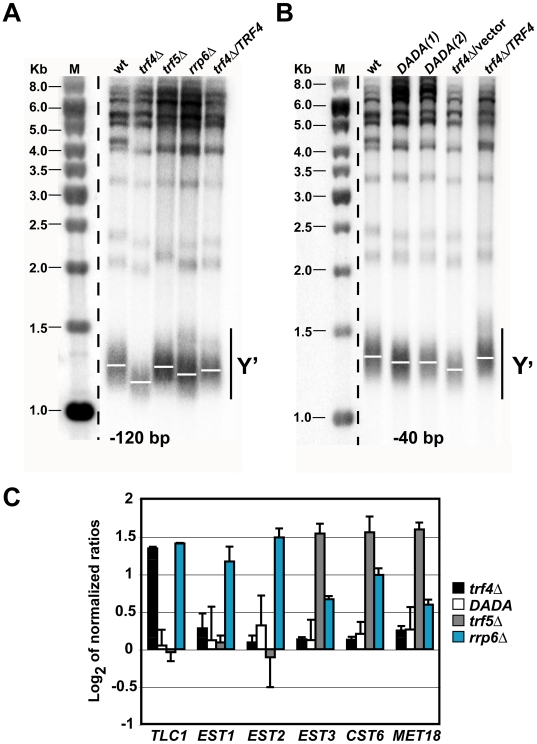
Trf4p promotes telomere maintenance and TLC1 regulation through a polyadenylation-independent mechanism.(A, B) Southern blot analyses of Y′-type telomeres was carried out with XhoI-digested DNA of RNA surveillance mutants (trf4Δ, trf4Δ/TRF4-DADA, trf5Δ, and rrp6Δ) of S. cerevisiae probed with telomeric sequences. Mutant strains are indicated at the top: wt corresponds to the wild-type BY4741 strain; trf4Δ/vector represents the trf4Δ mutant strain transformed with pNOPPATA1L. DADA(1) and DADA (2) represent two different clones of the trf4Δ/TRF4-DADA mutant. A marker (M) for DNA sizes in kilobases is shown to the left. Solid black bars flanked by Y′ shows the XhoI-digested Y′ DNA fragments, where white bars refer to the position of average size fragments. Numbers in brackets refer to the average shortening of the Y′-containing telomeres in the trf4Δ and trf4Δ/TRF4-DADA mutants relative to wt. (C) qRT–PCR analysis examining the levels of specified mRNAs and ncRNAs (TLC1) in four RNA surveillance mutants (trf4Δ, trf4Δ/TRF4-DADA, trf5Δ, and rrp6Δ). RNA amounts were normalized to ACT1 mRNA and compared to the isogenic WT strain. Relative changes of transcript abundances (log2 ratio scale) represent averages from two independent qRT-PCR analyses. The same RNA was used for the microarray analysis presented in Figure 1A.